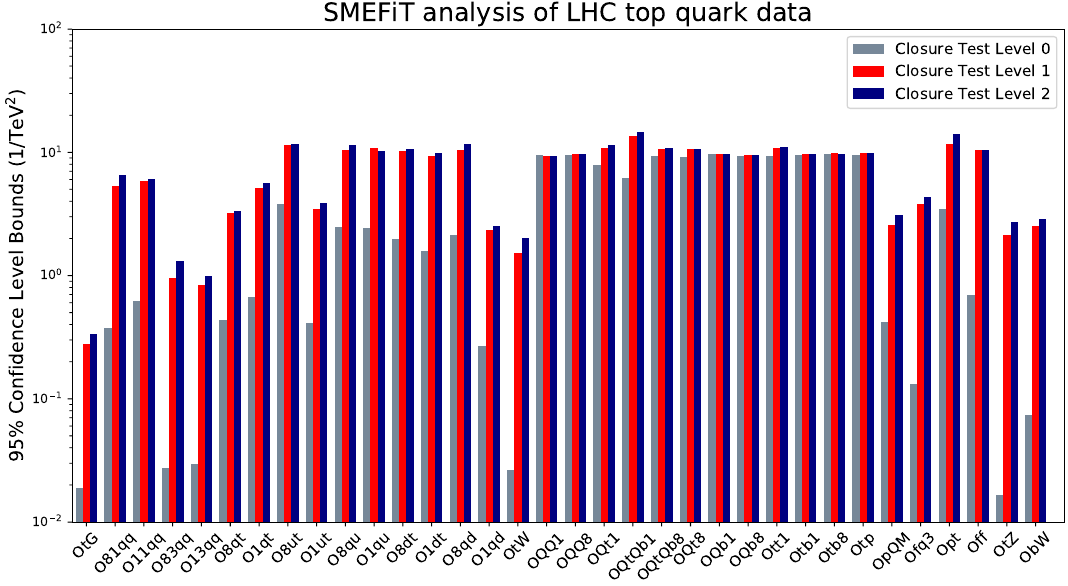
Figure 11 . The symmetrised 95% CL bounds for the (cid:12)t parameters, (cid:14)c tests at levels 0, 1a and